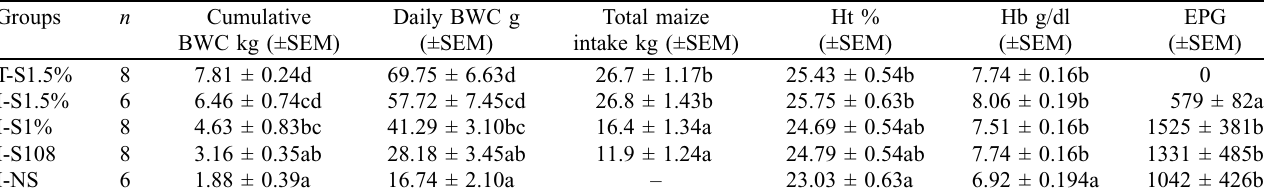
Means with different letters in the same column differ at P < 0.05. SEM = standard error of the mean. T-S1.5% = moxidectin-treated and supplemented with maize grain at 1.5% BW. I-S1.5% = naturally infected and supplemented with maize grain at 1.5% BW. I-S1% = naturally infected and supplemented with maize grain at 1% BW. I-S108 = naturally infected and supplemented with 108 g maize grain. I-NS = naturally infected, not